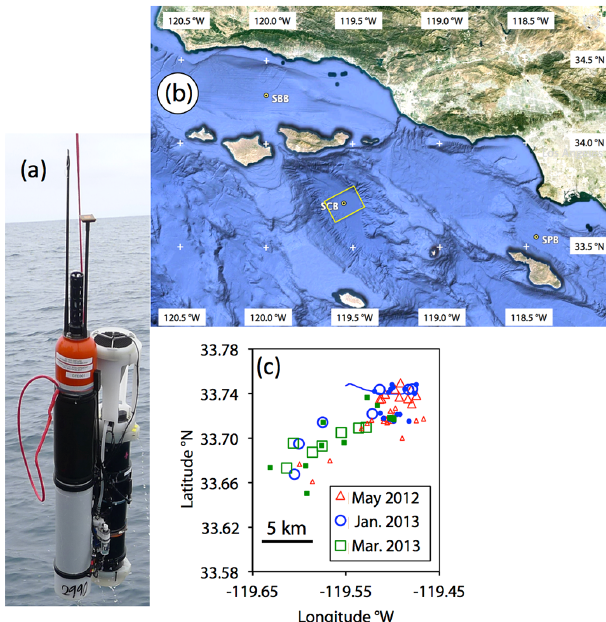
Figure 1. Left: Carbon Flux Explorer showing the Sounding Oceanographic Lagrangian Observer (SOLO) float and interfaced optical sedimentation recorder (OSR). Top right: relief map for Southern California Bight (Google Earth) centered on the Santa Cruz Basin (SCB) and our study area (shown in yellow). Also shown are locations of moored sediment trap deployments in the Santa Barbara Basin (SBB; Thunnel, 1998) and San Pedro Basin (SPB; Collins et al., 2011). Lower right: operations within study area. Surfacing positions of CFE001 during May 2012 (red trian- gles), January 2013 (blue circles), and March 2013 (green box); also shown is track for the surface-tethered OSR (BUOY-OSR) sys- tem (blue line) in January 2013; separation of CFE and BUOY-OSR was approximately 9km. Small symbols denote locations of con- ductivity, temperature, depth (CTD) rosette casts. All motion was to the southwest. CFE and BUOY-OSR deployments took place near 33.75 ◦ N, 119.5 ◦ W. CTD rosette profiles were taken within several kilometers of CFE and BUOY-OSR